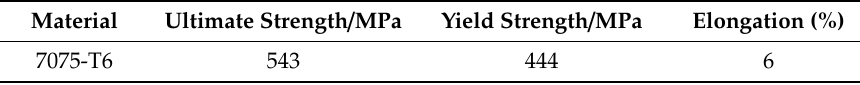
Table 2. Mechanical property of 7075-T6 aluminum